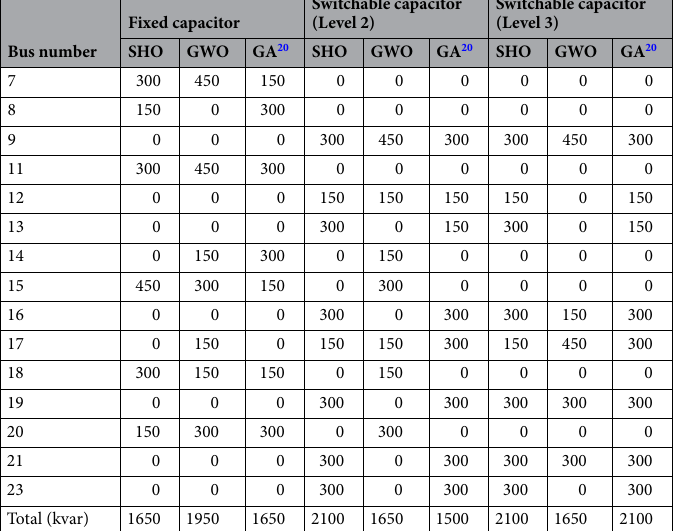
Table 5. optimal capacitor placement on 24-bus network with cosφ =